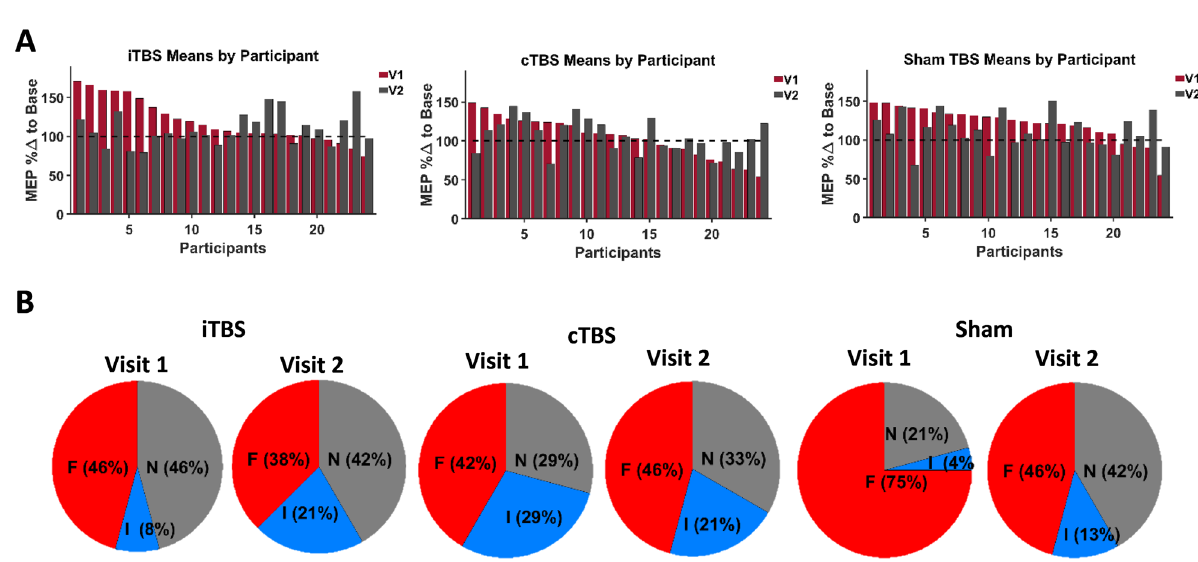
Figure 5. Individual responses and responder types. ( A ) Left, Middle, and Right Panel: Bar charts of individual participant (x-axis) mean MEP percentage change from baseline across all time points (y-axis) in V1 (maroon) and V2 (dark grey) of each TBS protocol (from left: iTBS, cTBS, and sham respectively). Participants are organized in descending order according to their V1 responses. Abbreviations: MEP %Δ to Base—motor evoked potential percentage change to baseline. ( B ) Left, Middle, and Right Panel: Pie charts of percentage of facilitators (F (red), ≥ 110%), inhibitors (I (blue), ≤ 90%) and non-responders (N (grey), 110% < µ > 90%) grouped by TBS protocol and visit number (from left: iTBS, cTBS, and sham